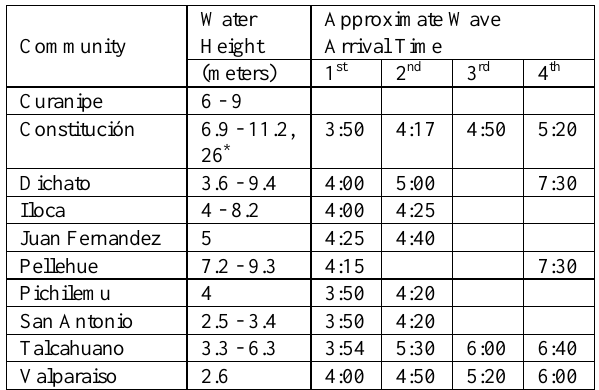
Figure 3. Real tsunami hazard map in Talcahuano area A conspicuous feature of the Chilean tsunami was its extreme variability in height, destructiveness, and wave arrival times as showed in Table 2. Local tsunami water height and arrival times were influenced by bathymetry, coastal topography, aspect, fault slips, and localized subsidence and uplift due to the earthquake. It was occurred on the February 27 th , 2010 at 3:34 hours, local time in Chile (06:34 hours UTC). The first tsunami surges generally arrived less than 30 minutes after the earthquake. There were three or four distinct surges. The third or the fourth were typically the largest, arriving between 90 minutes and four hours after the earthquake.